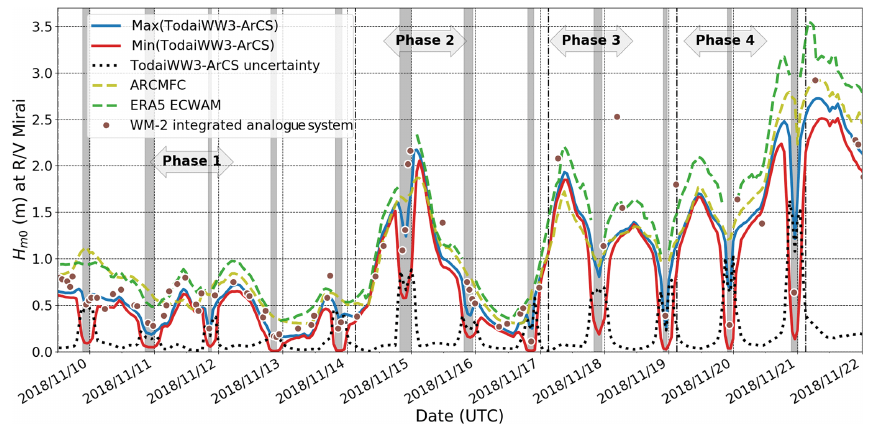
Figure 3. H m and (cid:49)H m values of TodaiWW3-ArCS estimates using various SIC products as sea ice forcing interpolated at R/V Mirai 0 0 positions are shown during the MIZ transect observation. The figure also shows the WM-2 data when R/V Mirai ship speed was < 2ms − 1 (refer to Appendix A for more details). Two independent predictions from ERA5 ECWAM and the ARCMFC wave model are also presented. Grey highlighted times indicate when the vessel was in ice-covered sea based on the ice navigator’s logs. Refer to Appendix D for details on